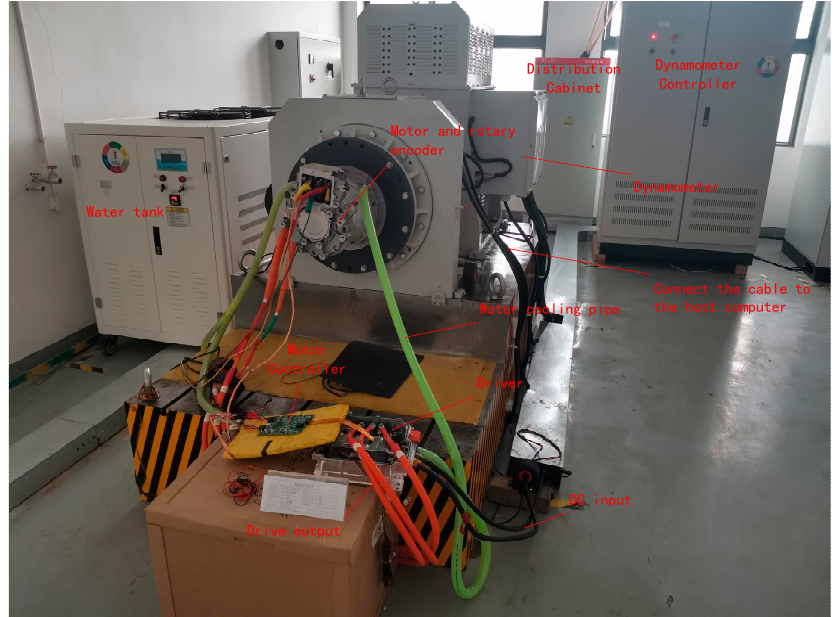
Figure 21. Experimental platform.